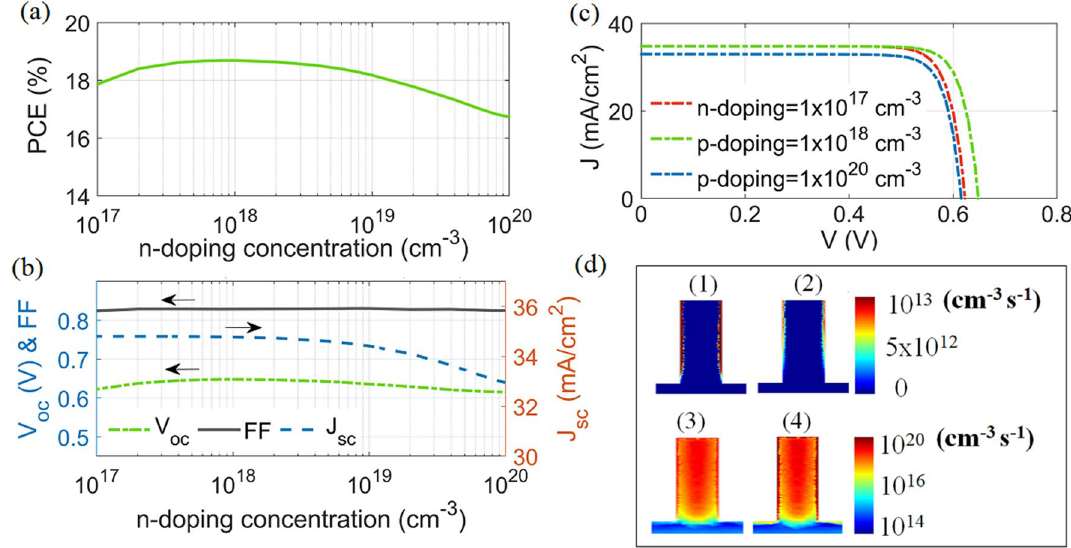
Figure 8. ( a ) PCE, ( b ) V oc , FF, and J sc versus the n-doped shell layer, ( c ) J–V characteristics and ( d ) SR rate for − 3 − 3 n-doping of (1) 1 × 10 18 cm , and (2) 1 × 10 20 cm , and the corresponding SRH rate is at (3) and (4) along